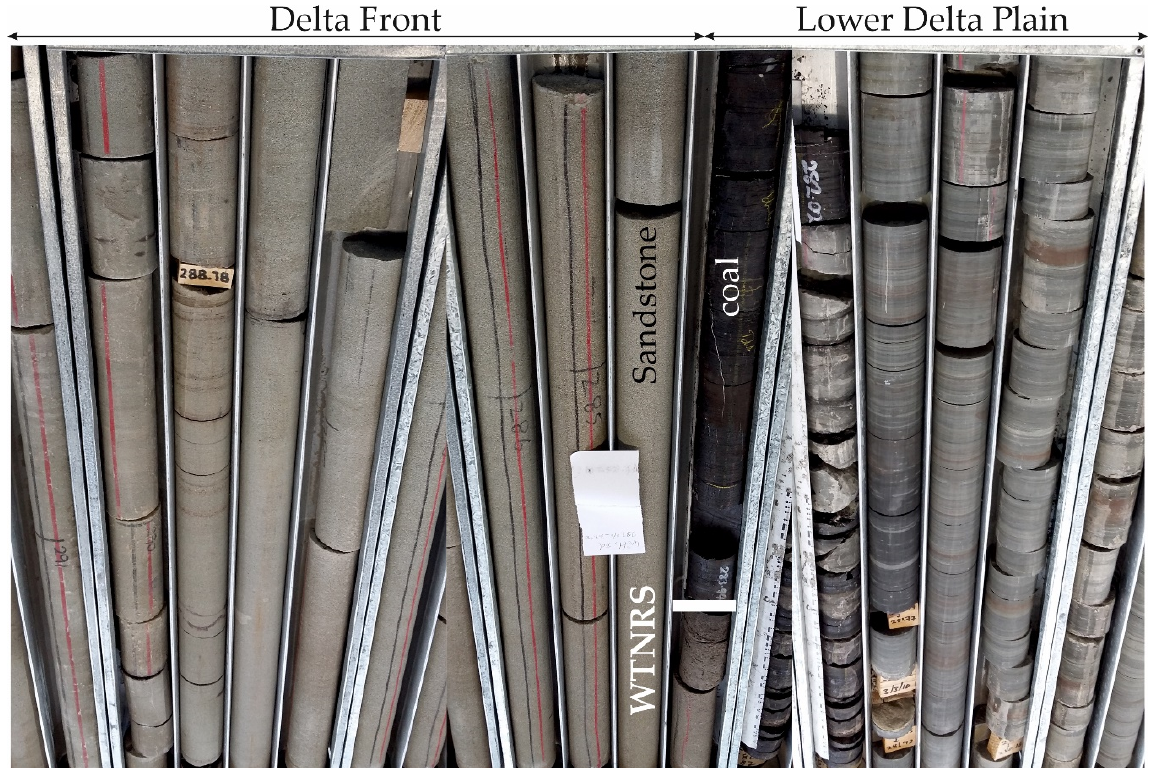
Figure 9. Core photographs illustrating the transition from delta-front to lower delta-plain deposits. Note the shift from thick-bedded, structureless sandstone (delta-front) to finer-grained heterolithics and coal-prone deposits (floodplain and overbanks of the lower delta-plain). The boundary between the two depositional environments corresponds to the within trend normal regressive surface (WTNRS) that is formed during highstand normal regression.